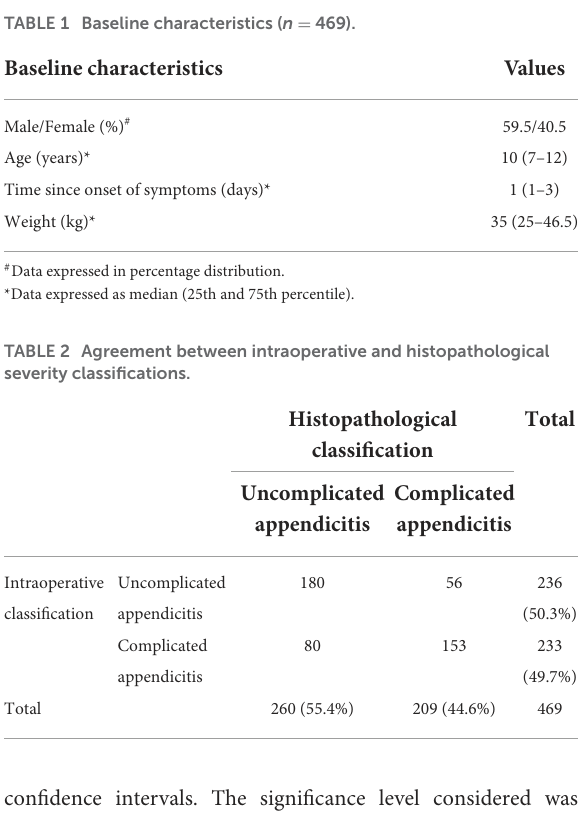
TABLE 1 Baseline characteristics ( n = 469).